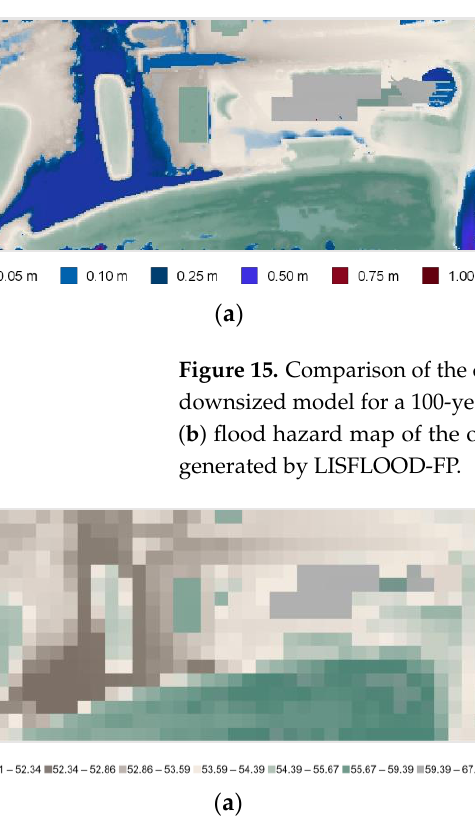
Figure 16. Downsizing the model without increasing the DEM resolution: ( a ) DEM of the downsized watershed with a resolution of one meter; ( b ) predicted hazard map for the downsized watershed with a DEM resolution of one meter.